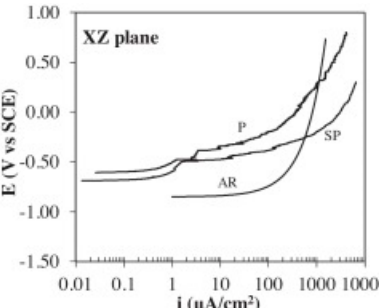
Figure 8. Polarization curves of printed AlSi10Mg alloy in diluted Harrison’s solution on XY ff erent surface treatment specimens with different surface treatment [91]. with di